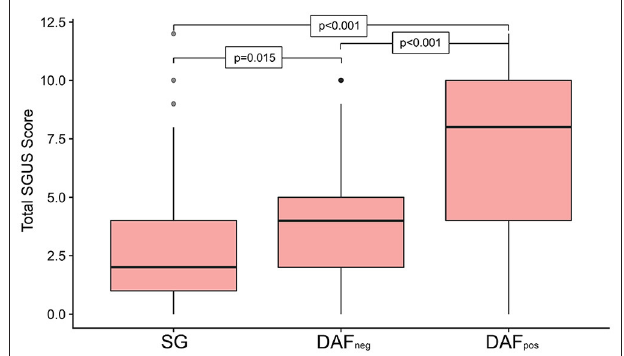
FIGURE 2 | Boxplot summarizing the cumulative ultrasound score for all four sites investigated, subdivided by phenotype group. Significant differences were seen across all the 3 groups, with patients in the Dryness with autoimmune features (DAF pos ) group returning the highest scores. Upper and lower box margins represent the interquartile range, with the central dark horizontal line representing the median score. Key: DAF neg , dryness without autoimmune features; DAF pos , dryness with autoimmune features; SG, somatic